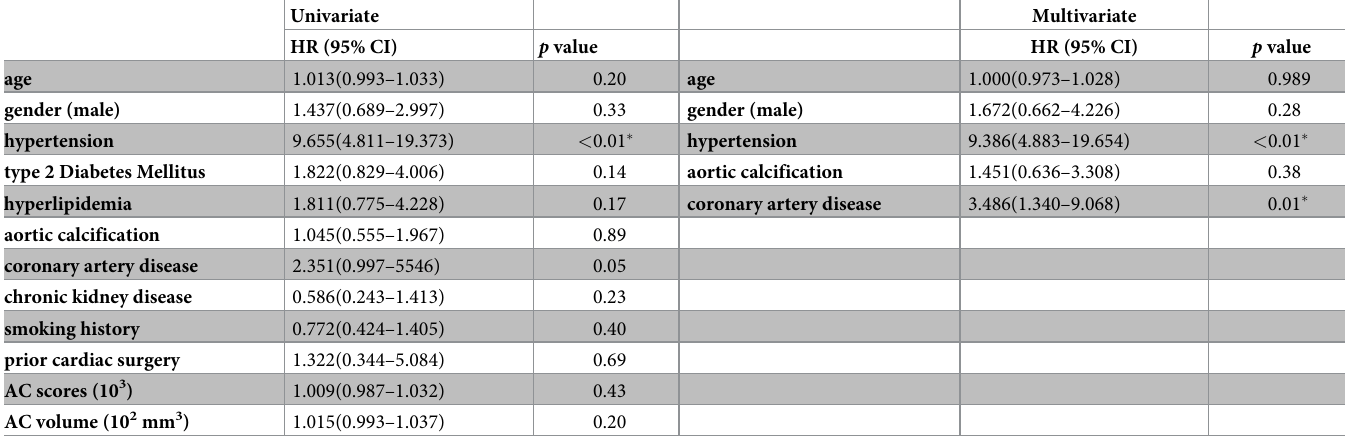
Table 2. Univariate and multivariate logistic regression analyses regarding the development of acute aortic